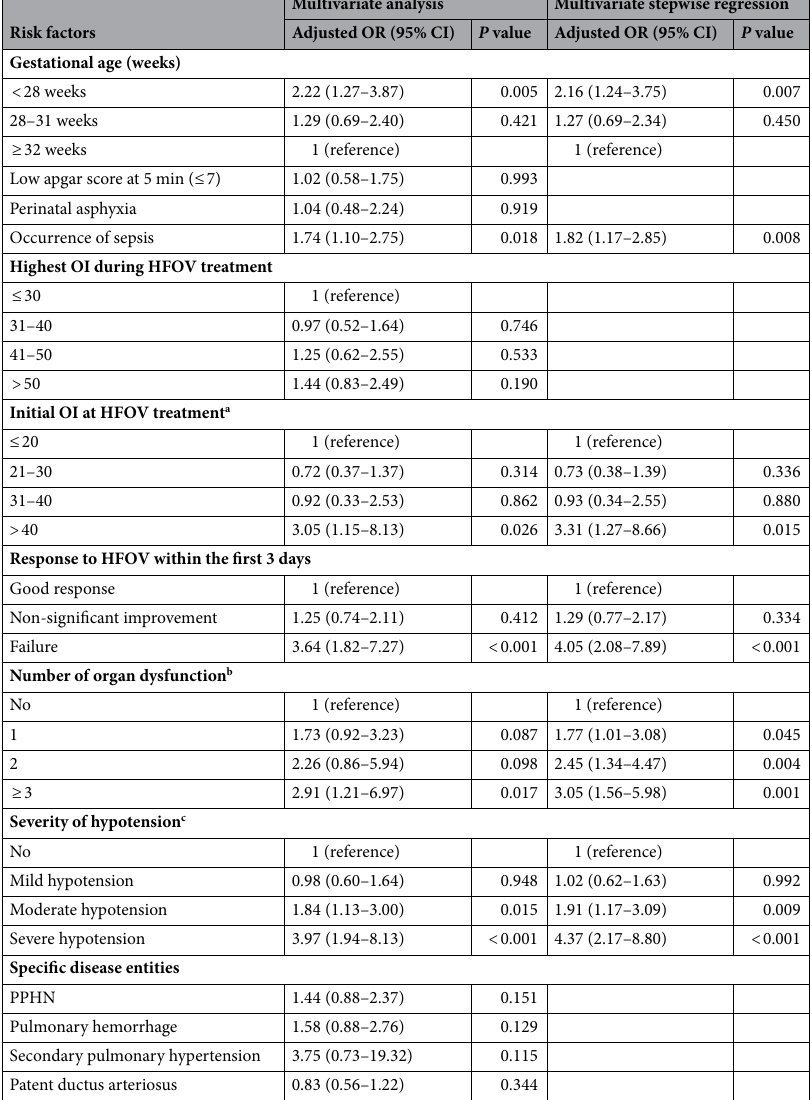
respiratory failure with/without documented PPHN 24 . Because a proportion of preterm neonates presenting with severe hypoxemia during the immediate postnatal period is associated with acute pulmonary hypertension 38 ,